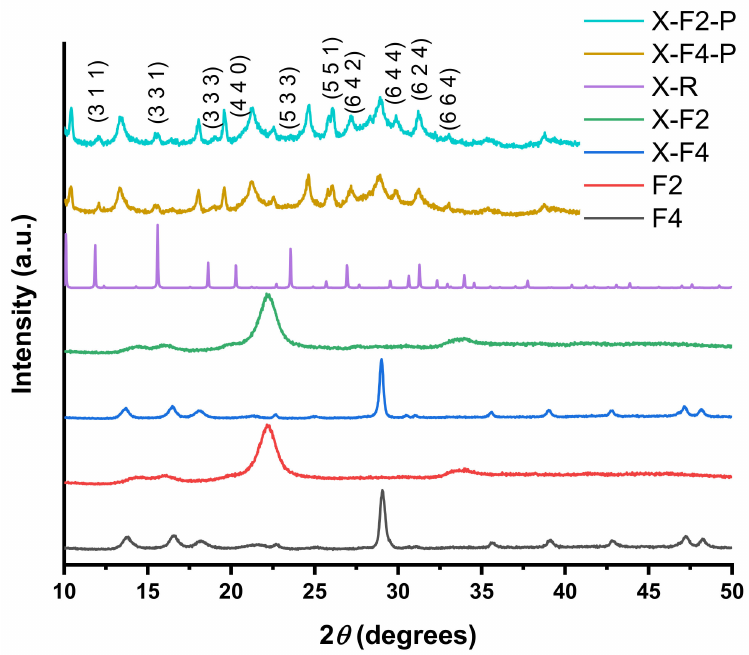
Figure 5. XRD-diffraction patterns corresponding to fabrics and zeolite